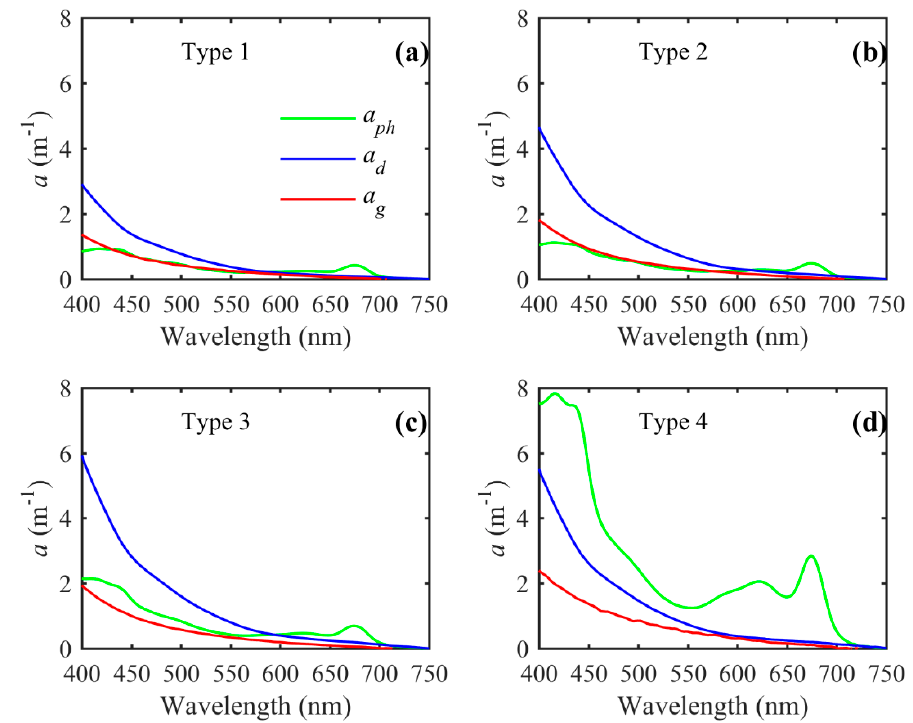
Figure 5. Mean spectrum of the absorption coefficients of phytoplankton ( a ph ), NAP ( a d ), and CDOM ( a g ) in each OWT: ( a ) type 1, ( b ) type 2, ( c ) type 3, and ( d ) type 4.